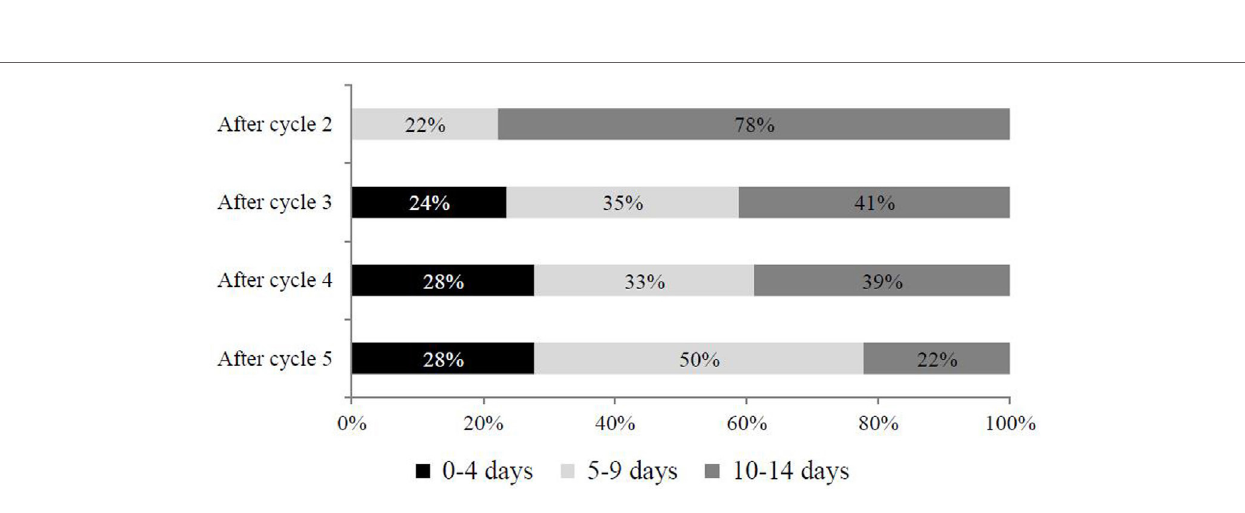
FigUre 4 | Evolution of migraine days per month during treatment among responders.